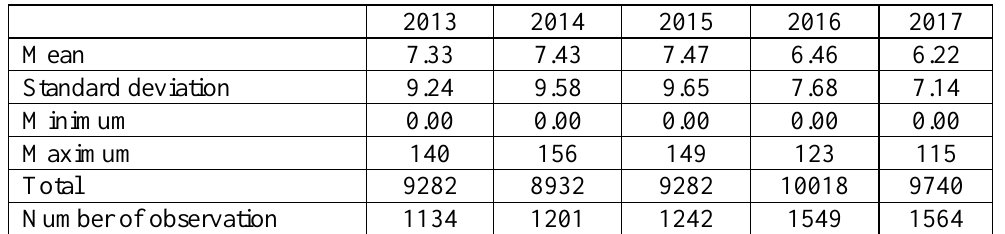
Table 5. Descriptive statistics of degree